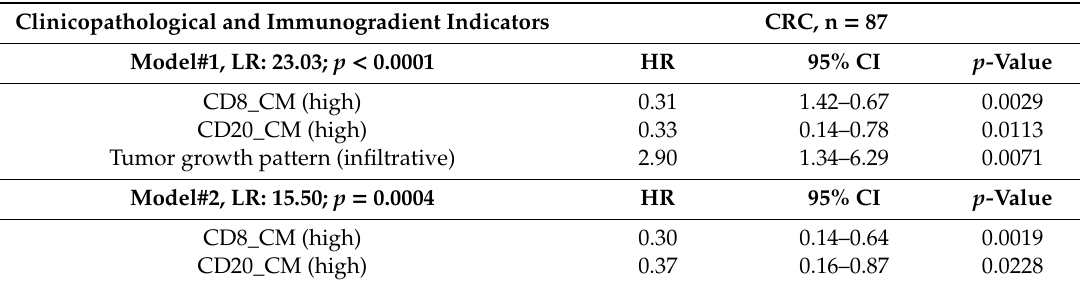
Table 4. Multiple Cox regression models for patient overall survival.